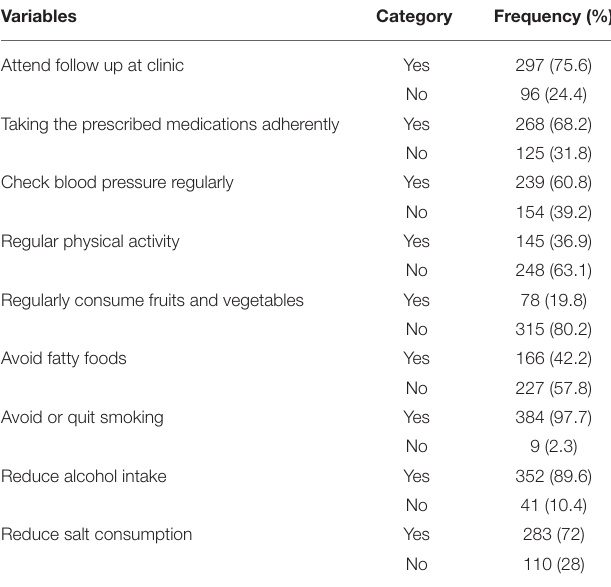
TABLE 5 | Stroke prevention practice of patients attending in chronic illness follow-up Clinic of University of Gondar Comprehensive Specialized Hospital, Northwest, Ethiopia, 2021 ( n =